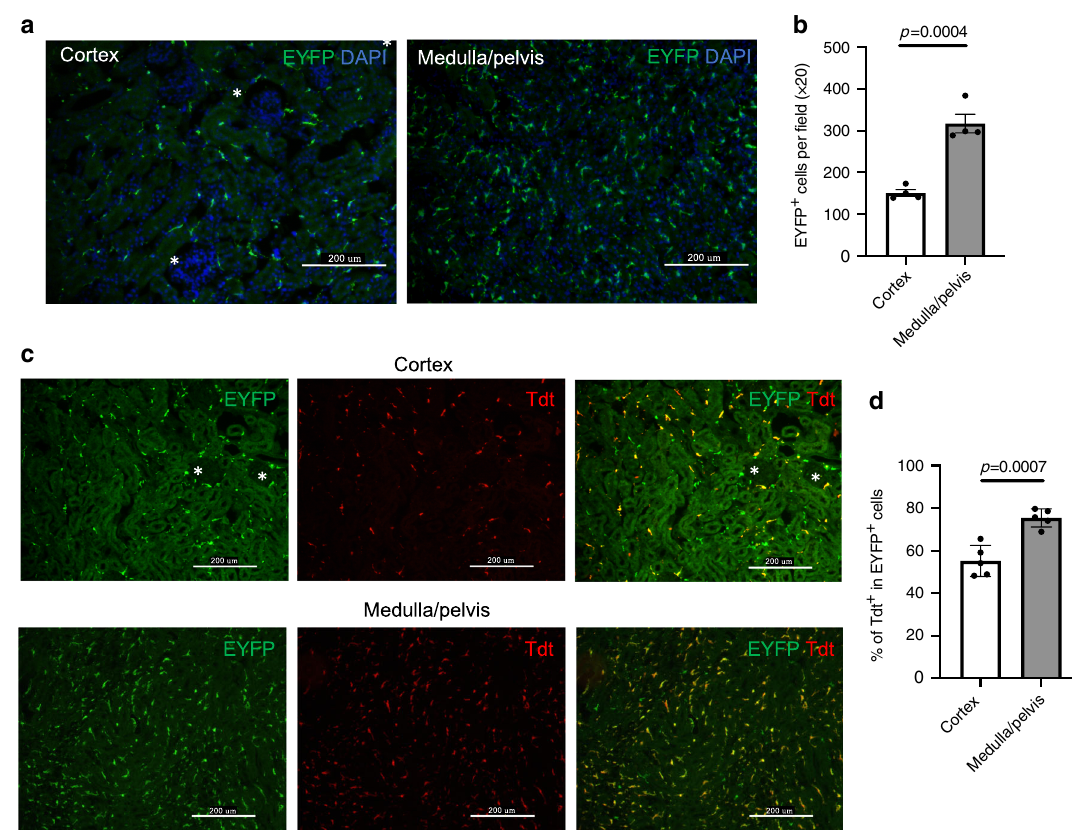
Fig. 3 Localization of EMRMs and BMRMs in kidney. a Representative immuno fl uorescence (IF) staining of EYFP (green) and DAPI (blue) and b quanti fi cation of EYFP + cells in kidney cortex and medulla/pelvis of adult Cx3cr1CreER + / − mice. Asterisk indicate glomerulus in cortex. Each dot in b represents the average cell numbers per fi eld (×20 magni fi cation) from one mouse (mean ± s.e.m., two-tailed unpaired t -test, n = 4 mice per group). c Representative IF staining of EYFP (green) and Tdtomato (Tdt, red) in cortex and medulla/pelvis of adult E18.5-Tam- Cx3cr1CreER + / − /R26Tdt + / − mice. Yellow staining cells in merged image are EMRMs. Asterisk indicate glomerulus in cortex. d Quanti fi cation of the percentage of Tdt + EMRMs in all RMs of cortex and medulla/pelvis. Each dot represents the average cell numbers per fi eld (×20 magni fi cation) from one mouse (mean ± s.e.m., two-tailed unpaired t -test, n = 5 mice per group). Source data are provided as a Source Data fi